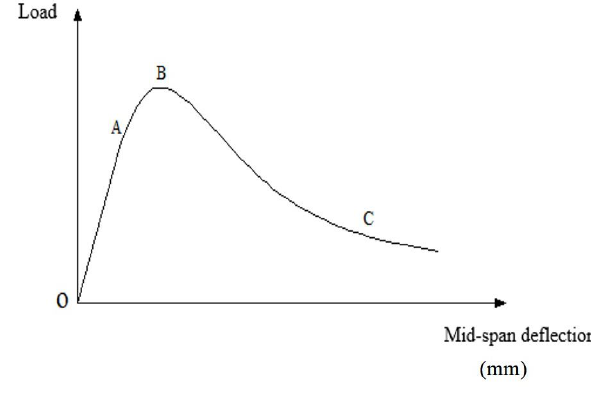
Figure 3: A typical curve of load vs. mid-span